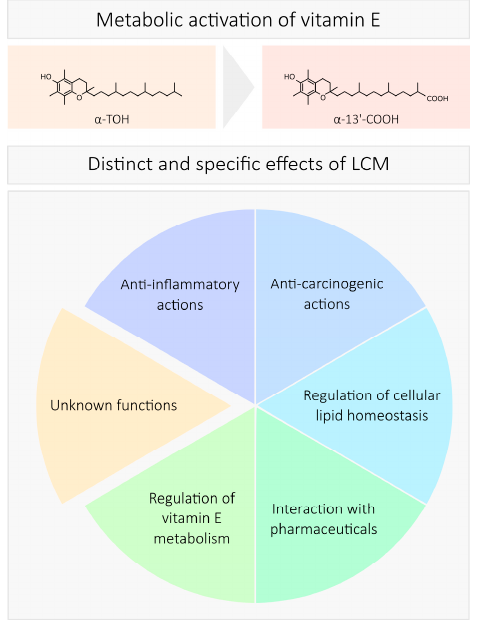
Figure 2. Reported biological functions of the LCMs of vitamin E.